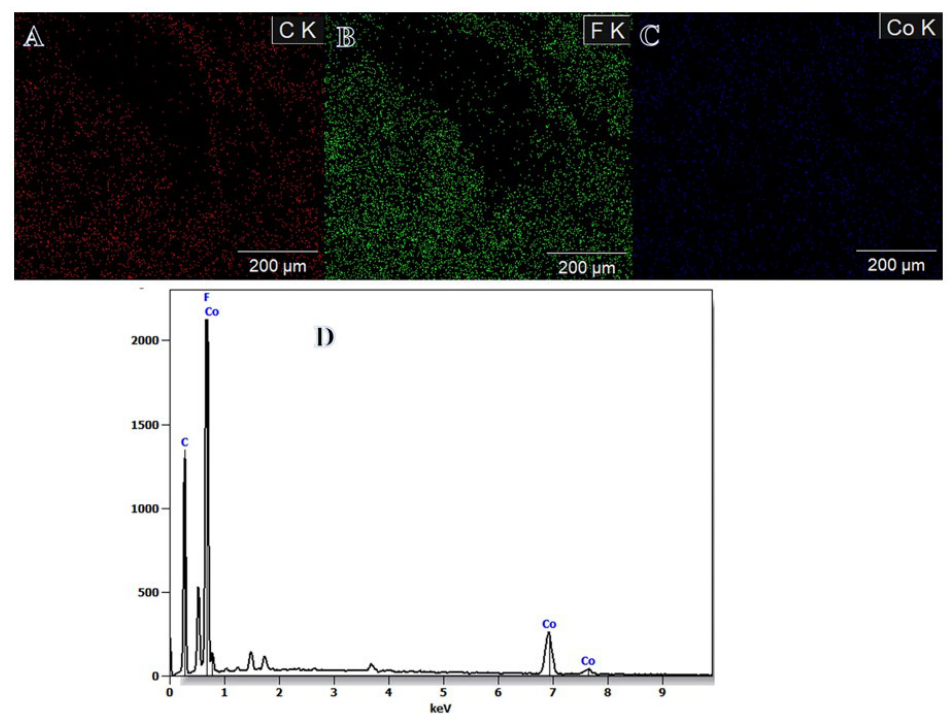
Figure 2. Mapping distribution of carbon ( A ); fluorine ( B ); cobalt ( C ) in the PVHF-40 membrane, and ( D ) EDX result of mapping image.